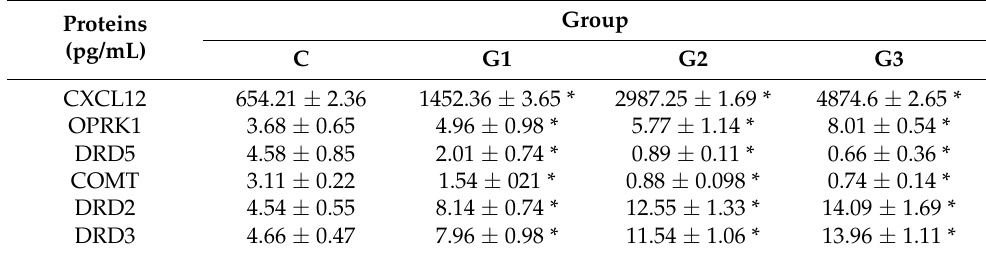
Table 2. Serum dopamine-related protein expression profile in the study and control groups ( p < 0.05).